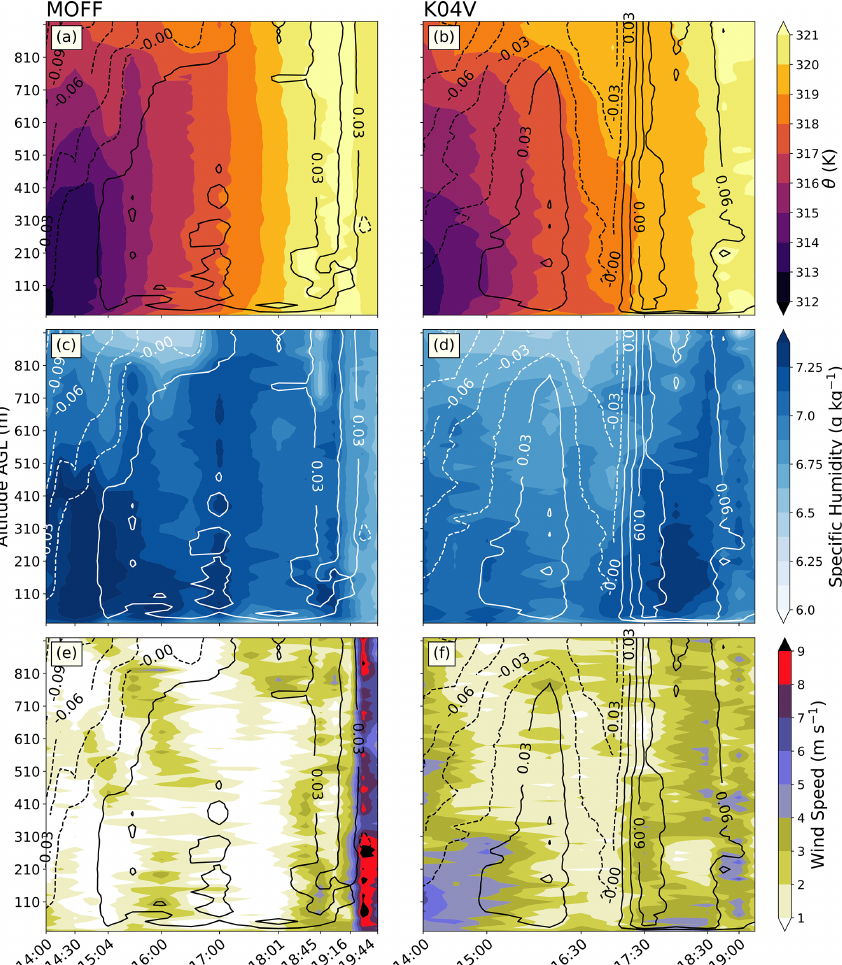
Figure 8. Same as Fig. 3 but on 15 July 2018, and panels (a) , (c) , and (e) are at the MOFF site, and panels (b) , (d) , and (f) are at the K04V